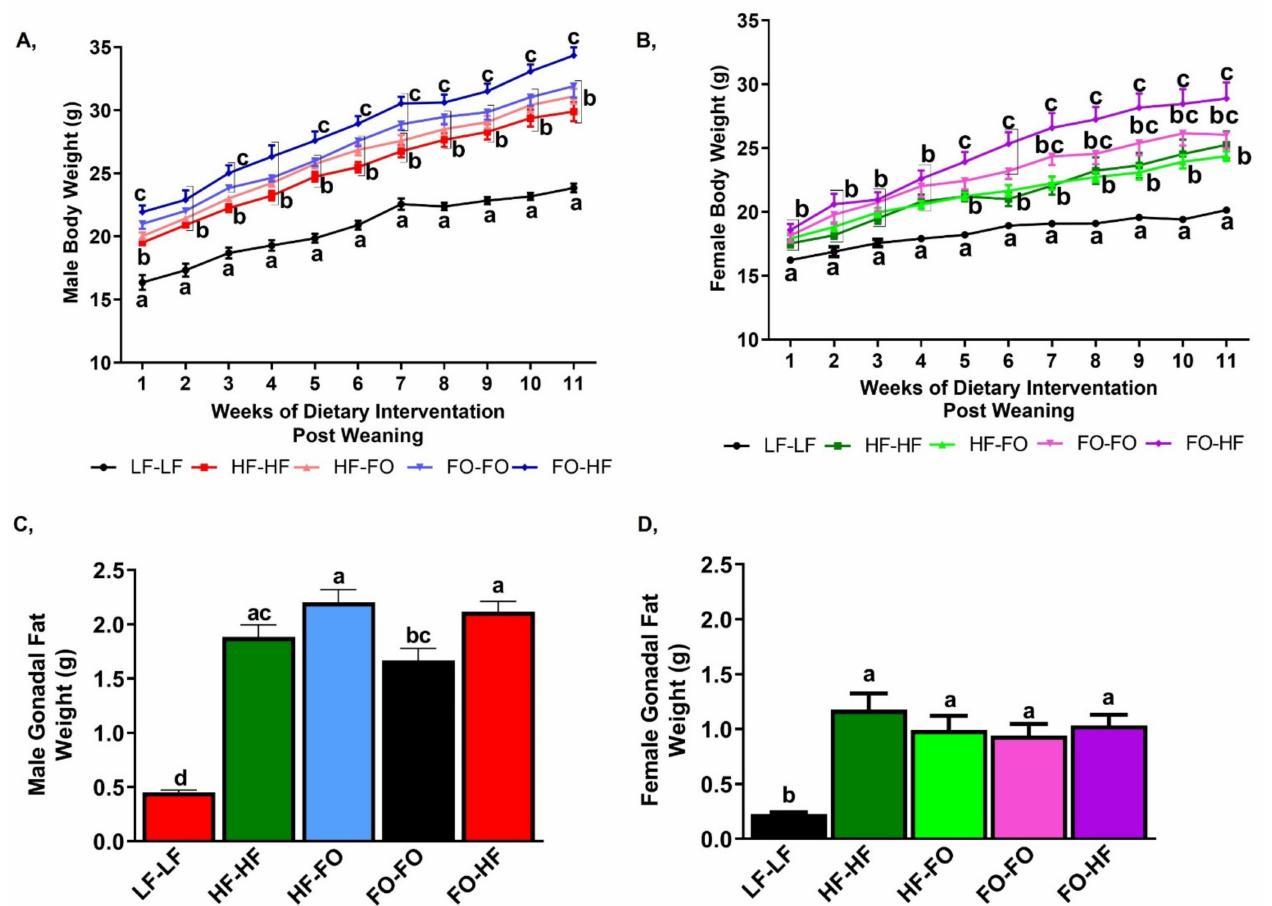
Figure 2. Fish oil effects on post weaning body weight in male and female mice: ( A , B ) Weekly body weight measure- ments post weaning in ( A ) male offspring, ( B ) female offspring. ( C , D ) Mean gonadal fat weight measured during sacrifice in ( C ) male mice ( D ) female mice. Data is presented as mean ± SEM (n = 10–13). Statistical differences are determined for each time point for line graphs. Common letters indicate no differences across the groups at each specific time point. Common letters on the error bars indicate no significance (e.g., “a” is significantly different from “b” and “ab” indicates no significance compared to “a” and